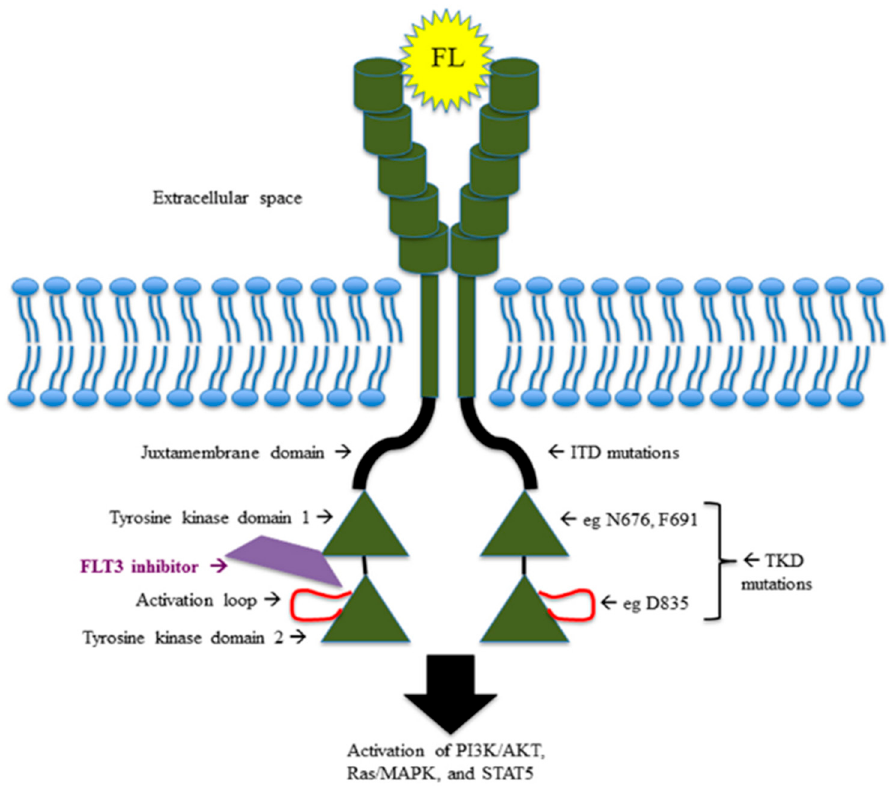
Figure 1. FLT3 pathway and FLT3 mutations.